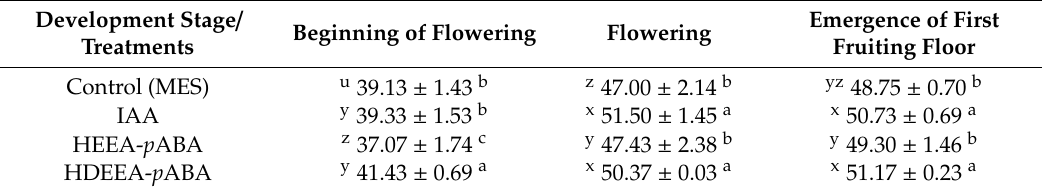
Table 7. E ff ect of treatments on chlorophyll content (SPAD) of tomato plants’ foliar apparatus (cv. Tomtim) in di ff erent stages of